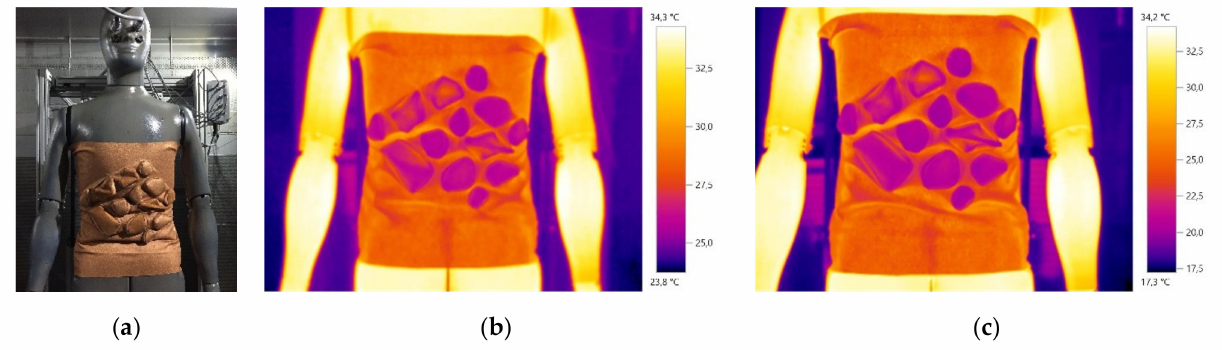
Figure 9. The M01 module tested in the laboratory: ( a ) Photography; ( b ) Thermal image of the diurnal simulation; ( c ) Thermal image of the nocturnal simulation.